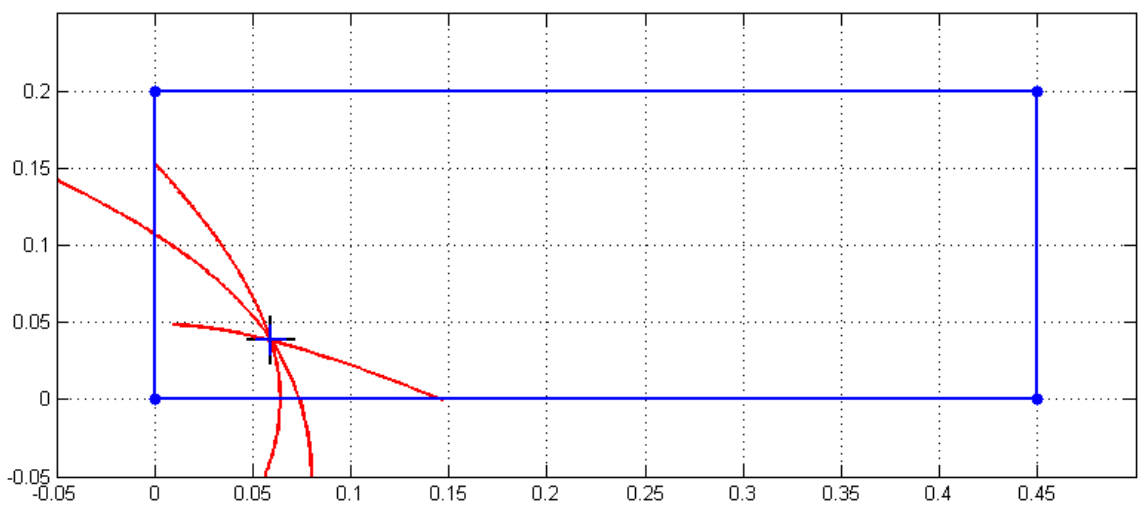
Figure 13. Experimental impact detection and location for the given example (distance units in m).